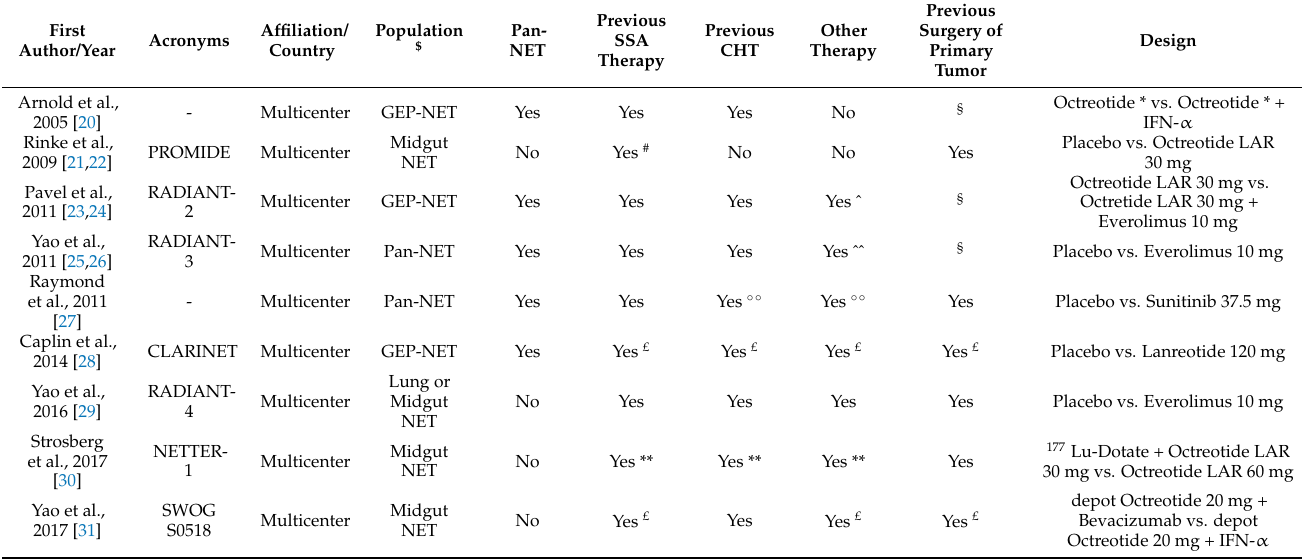
Table 1. Characteristics of the nine included